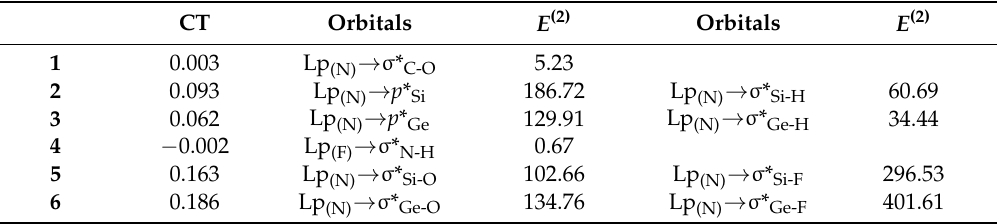
Table 3. Charge transfer (CT, e) and second-order perturbation energies ( E (2) , kJ/mol) in the complexes. CT